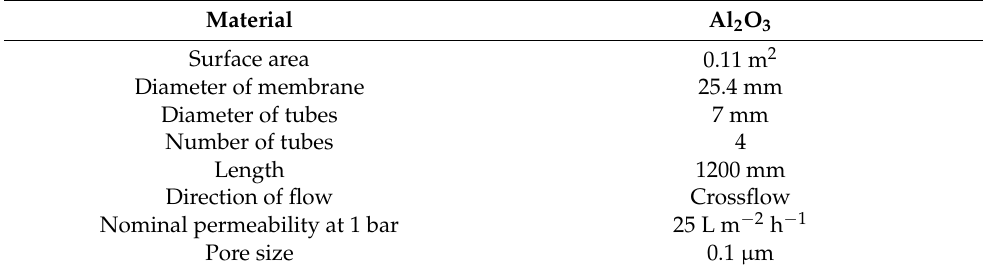
Table 2. Ceramic micro-filtration (CMF) membrane specification (Inopor GmbH) .